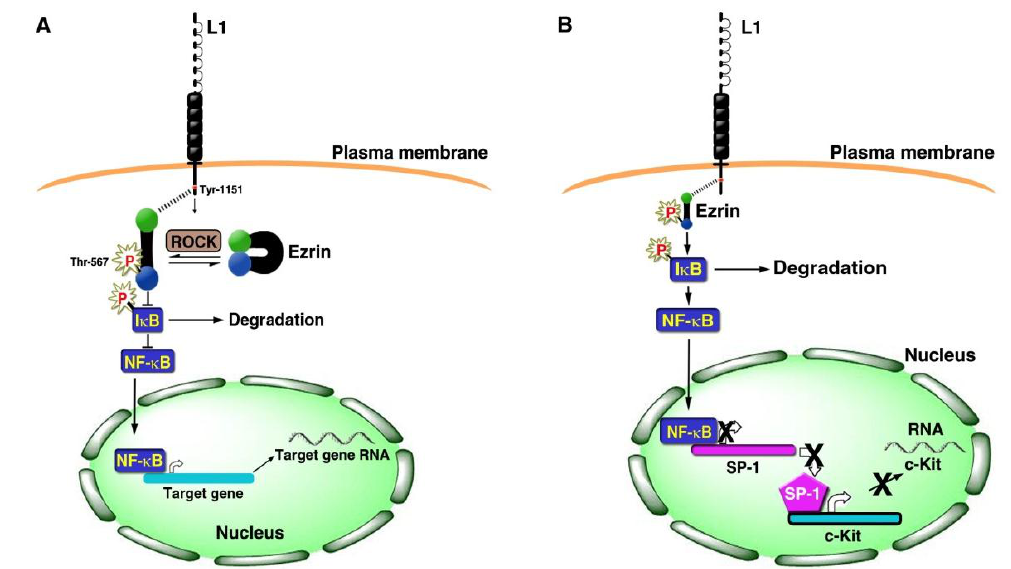
Figure 2. Schematic representation of L1-mediated signaling that involves ezrin and NF-κB. ( A ) Ezrin is activated by phosphorylation on threonine 567 (Thr-567) by ROCK that enables its association with the cytoplasmic tail of L1 involving tyrosine 1151 (Tyr-1151). The relocalization of ezrin in complex with L1 is involved in the recruitment of IκB to this complex, its enhanced phosphorylation and degradation by the proteasome followed by the release of NF-κB to migrate into the nucleus and activate target genes; ( B ) The L1-ezrin-NF-κB signaling is also employed in the inhibition of c-Kit transcription, indirectly, by the blocking of SP-1 transcription by NF-κB (modified from references [39,41]).